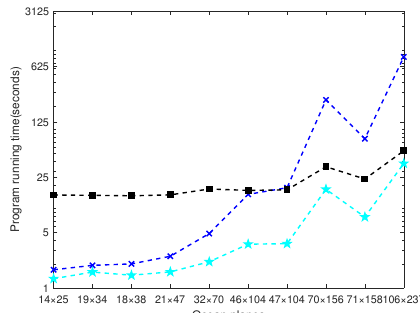
Figure 11. The working time of the improved A* algorithm and the working time of the neural network model when creating paths in the ten grid maps. The working time of the improved A* algorithm is indicated by the blue line. The working time of the neural network model is indicated by the black line when the parallel computing channel is automatically turned on. The neural network model working time when parallel computing is turned on early is indicated by the cyan line.